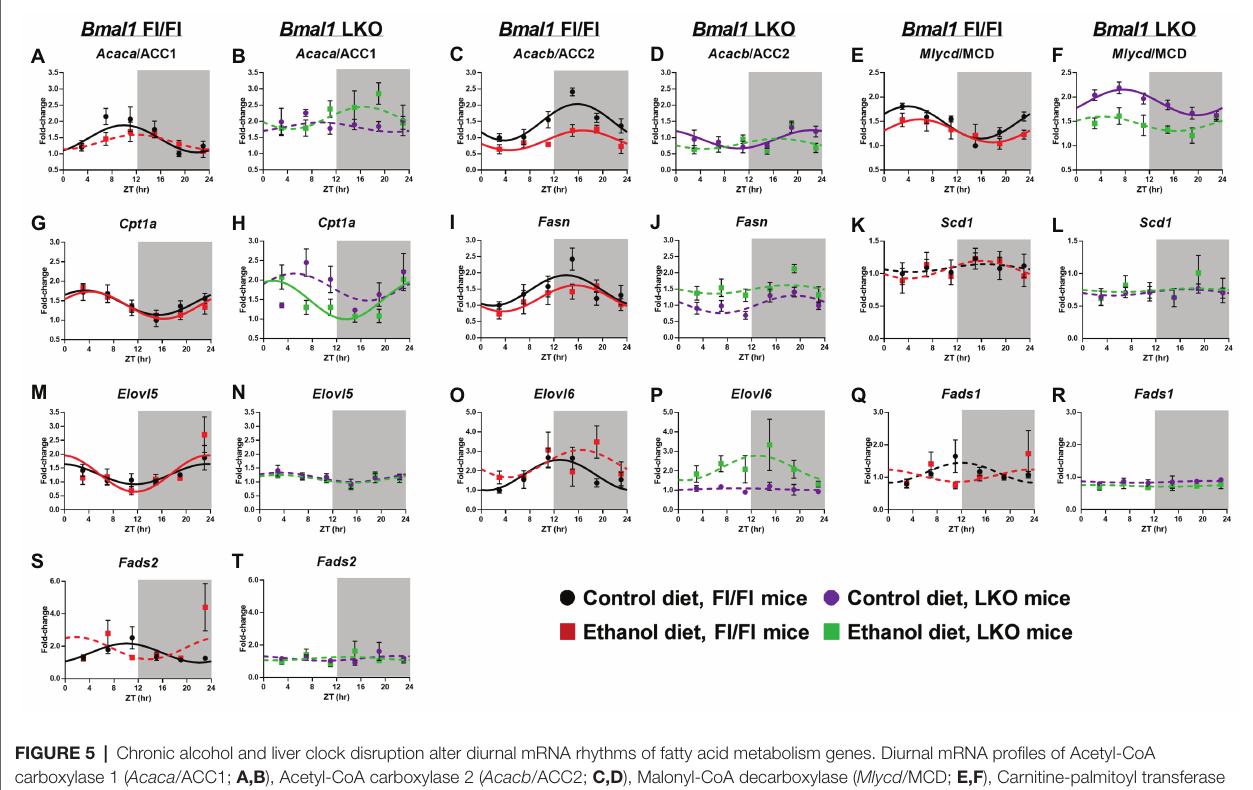
FIGURE 5 | Chronic alcohol and liver clock disruption alter diurnal mRNA rhythms of fatty acid metabolism genes. Diurnal mRNA profiles of Acetyl-CoA carboxylase 1 ( Acaca /ACC1; A,B ), Acetyl-CoA carboxylase 2 ( Acacb /ACC2; C,D ), Malonyl-CoA decarboxylase ( Mlycd /MCD; E,F ), Carnitine-palmitoyl transferase 1A ( Cpt1a ; G,H ), Fatty acid synthase ( Fasn ; I,J ), Stearyl-CoA desaturase 1 ( Scd1 ; K,L ), Elongation of very long chain fatty acids protein 5 ( Elovl5 ; M,N ), Elongation of very long chain fatty acid protein 6 ( Elovl6 ; O,P ), Fatty acid desaturase 1 ( Fads1 ; Q,R ), and Fatty acid desaturase 2 ( Fads2 ; S,T ) were measured in livers of control-fed (black) and alcohol-fed (red) Bmal1 Flox/Flox (Fl/Fl) and control-fed (purple) and alcohol-fed (green) Bmal1 liver-specific knockout (LKO) mice at ZT 3, 7, 11, 15, 19, and 23 (ZT 0: lights on/inactive period, ZT 12: lights off/active period, gray area) by RT-PCR. Data are presented as a fold-change to the Bmal1 Fl/Fl control diet trough time-point and normalized to Ppia . Data are expressed as mean ± SEM for n = 4–8 mice/genotype/diet/time point. Solid lines indicate rhythmic mRNA levels and a significant cosine fit, whereas dashed lines indicate arrhythmicity and a non-significant cosine fit. Results for Cosinor and ANOVA analyses are provided in Supplementary Tables 4 and 5 ,